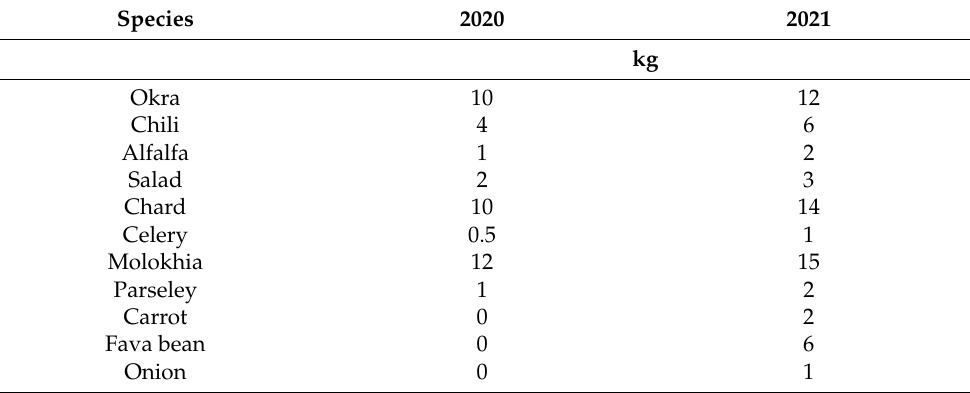
Table 3. First approach for implementing the Maison des semences with local traditional annual species and quantity of seeds produced by farmers for this purpose (2020 and predictive